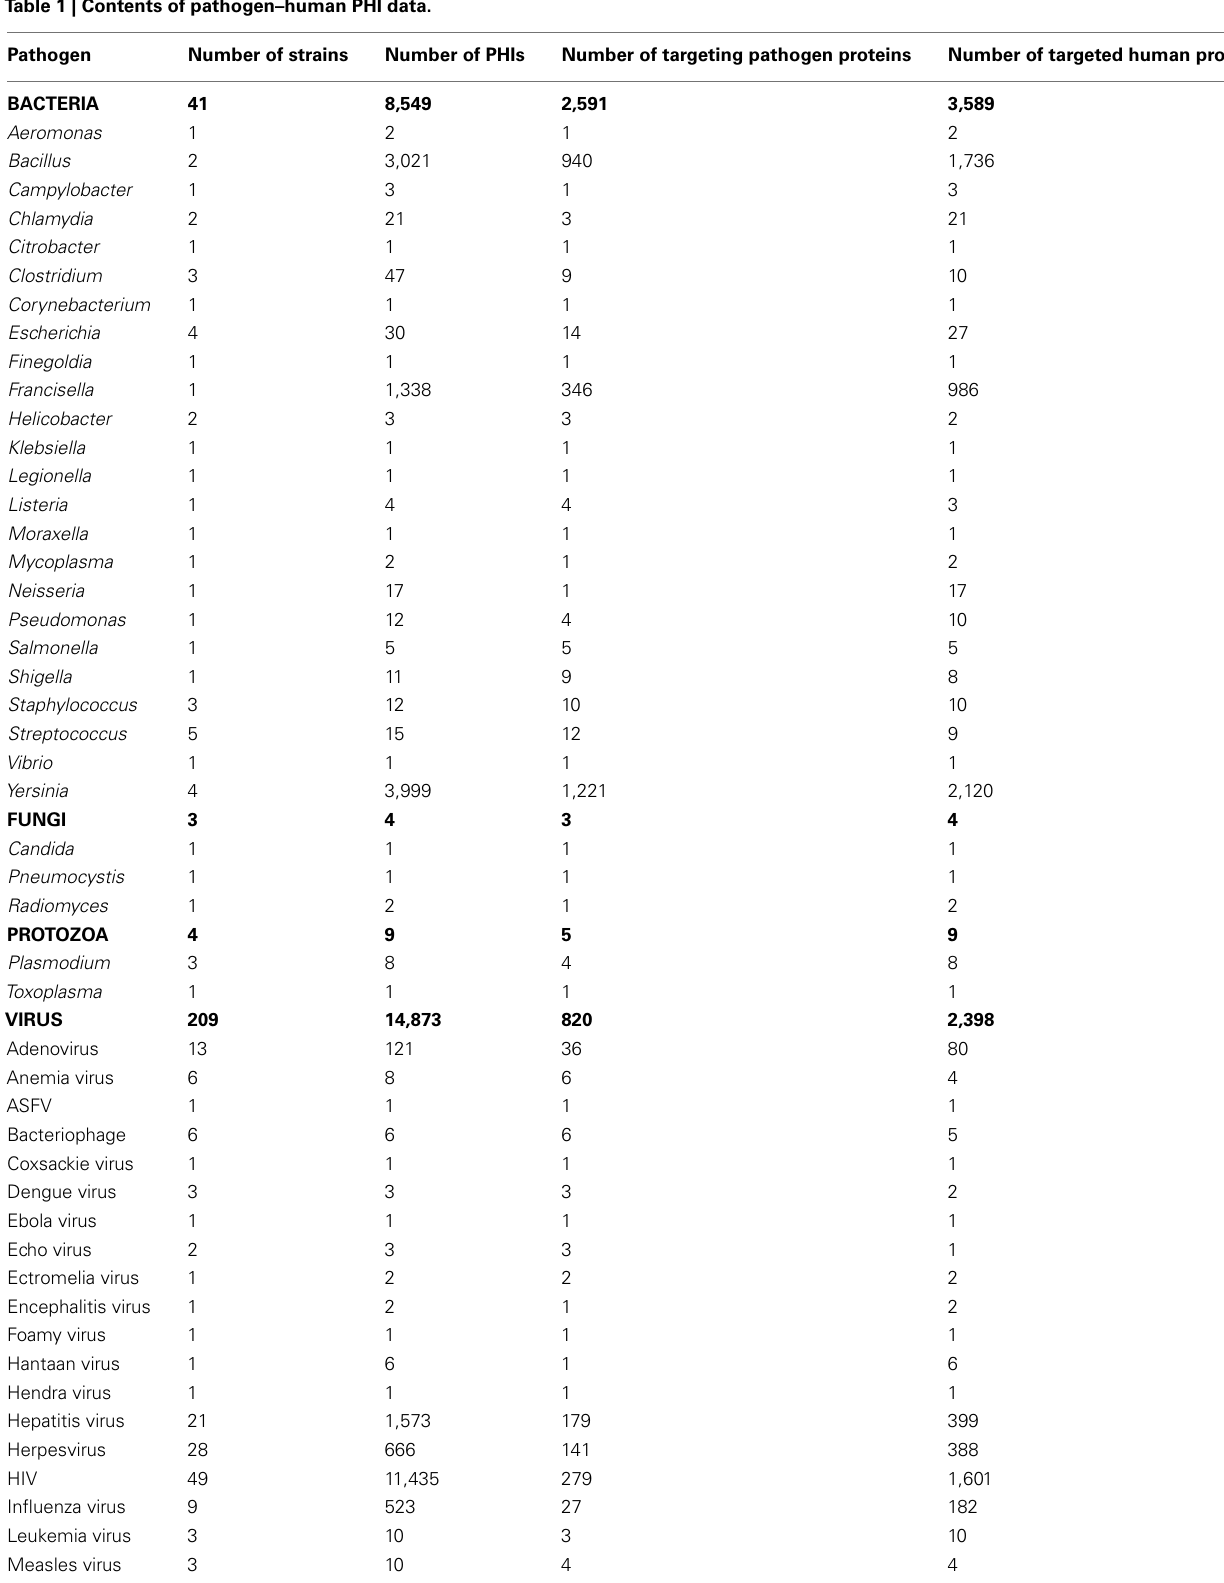
Table 1 | Contents of pathogen–human PHI